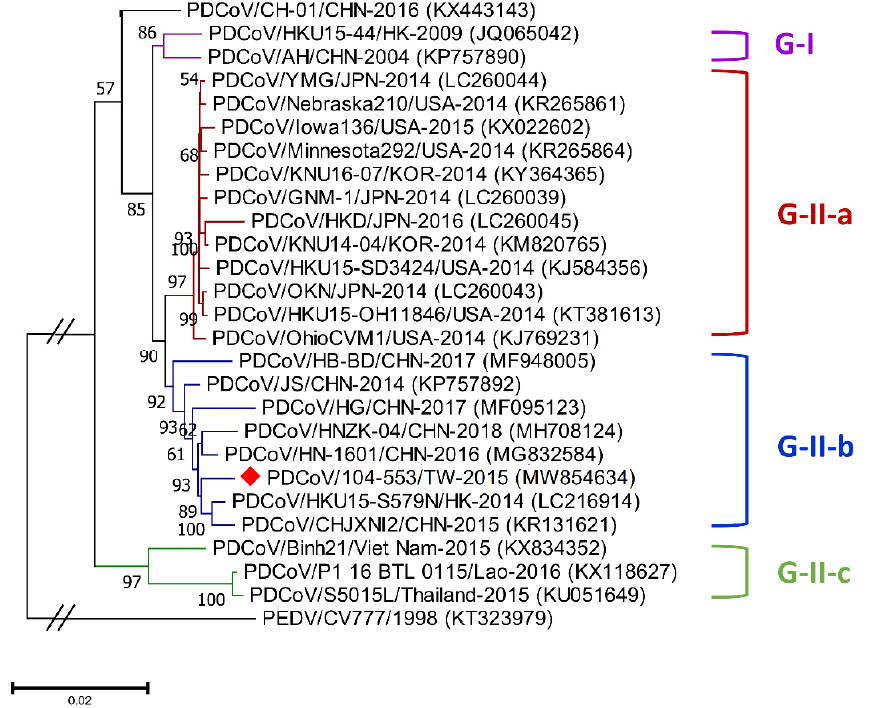
Figure 1. Phylogenetic trees based on the whole-genome sequencing of porcine deltacoronavirus (PDCoV) variants were established through maximum likelihood estimation (MLE), using the Kimura 2-parameter (K2P) model. PEDV/CV777/1998 served as an out-clade control. Previously identified global PDCoV strains are labeled as different genogroups in different colors on the right. The red solid diamond represents the local PDCoV isolate in 2015. The scale bar indicates nucleotide substitutions per